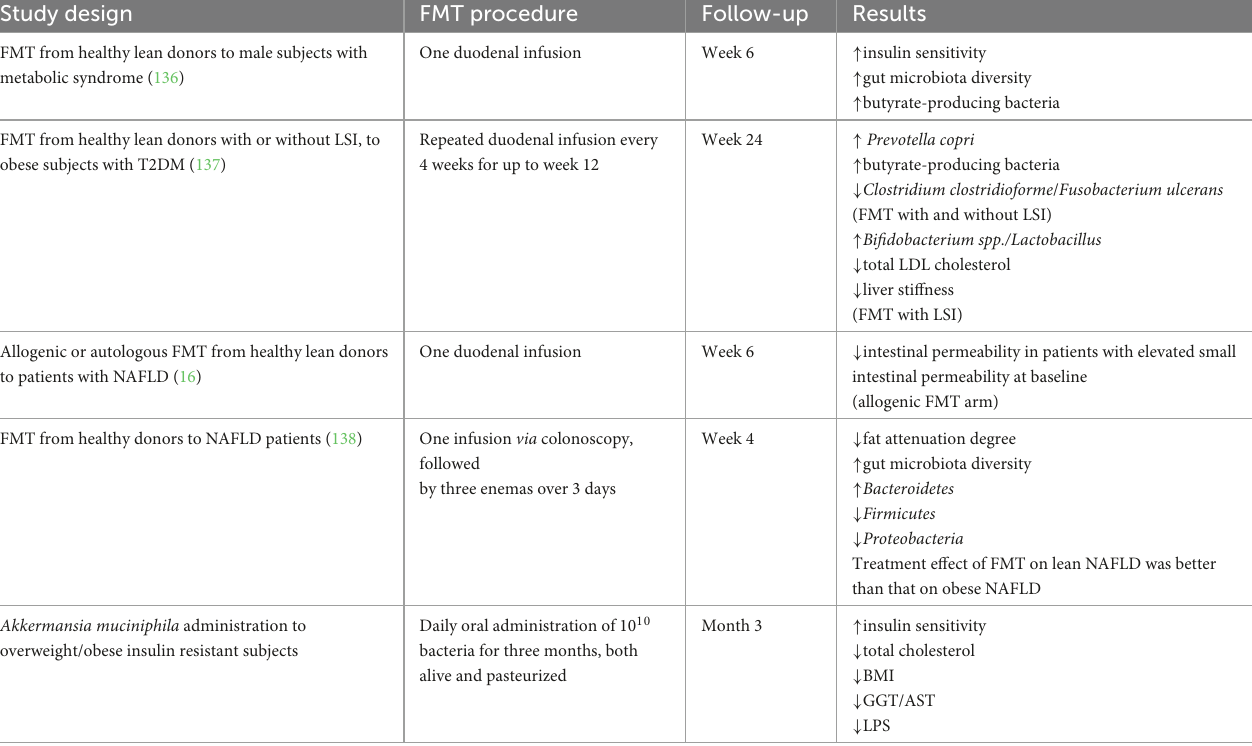
TABLE 2 Human studies evaluating the efficacy of fecal microbial transplantation (FMT) or next generation probiotics for the treatment of NAFLD. Study design